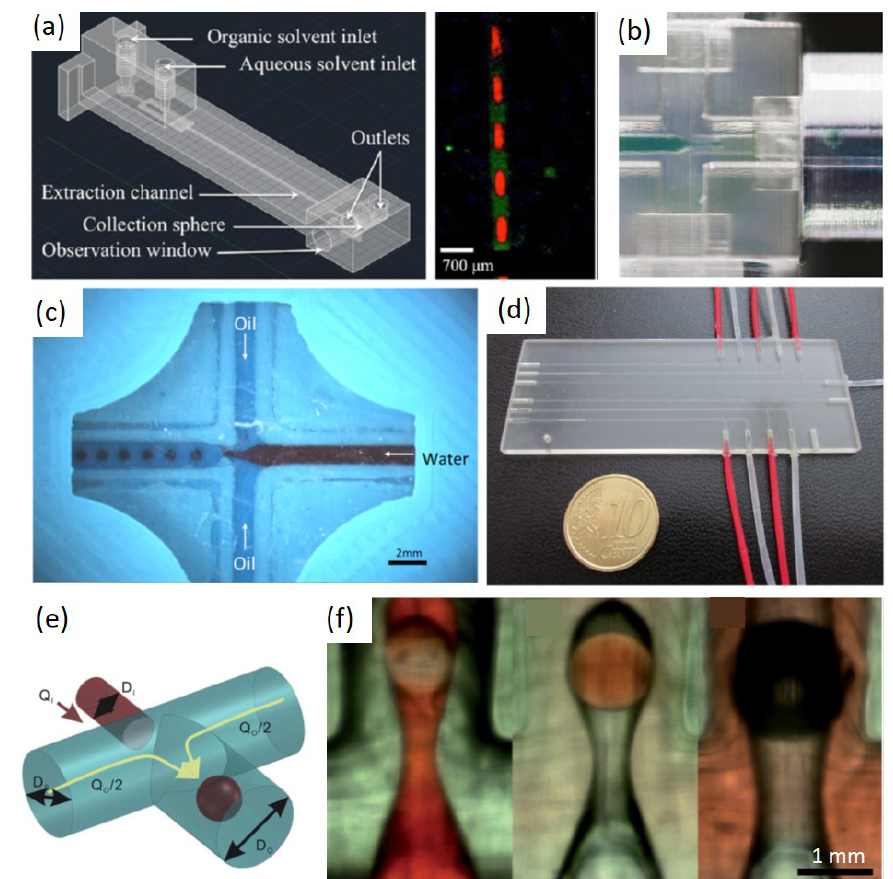
Figure 6. Current 3DP techniques applied in droplet microfluidics. ( a ) A flow-focusing structure printed by a desktop DLP printer. ( b ) A flow-focusing structure printed by SLA printing. ( c ) A flow-focusing structure printed by FDM printing. ( d ) A T-junction structure printed by Polyjet printing. ( e ) A schematic of non-planar structure printed by a desktop SLA printer and ( f ) different double emulsions were produced in this non-planar structure. Reproduce of